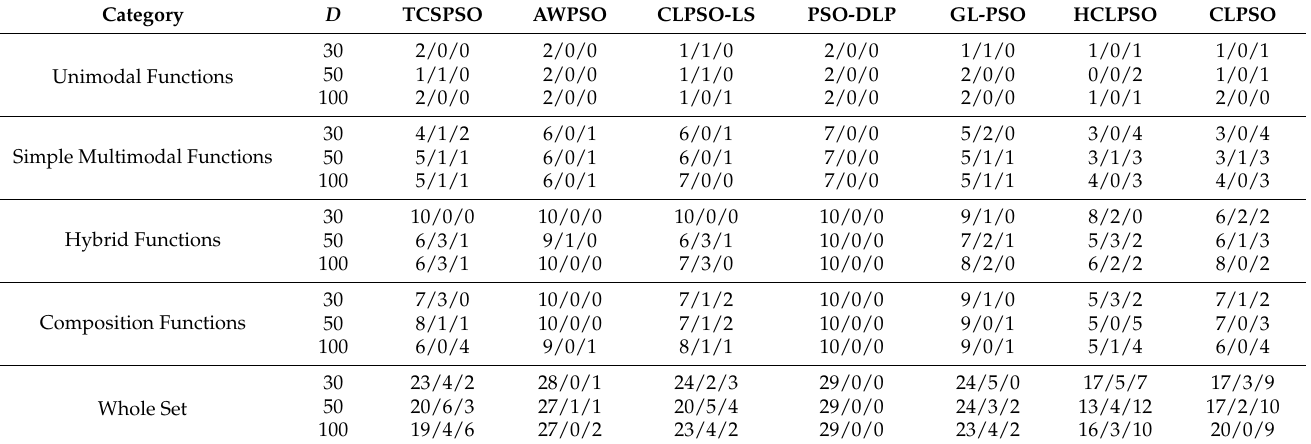
Table 6. Statistical comparison results between PCLPSO and the seven compared PSO methods on the CEC 2017 benchmark problem set with the three dimension sizes in terms of “ +/=/ −